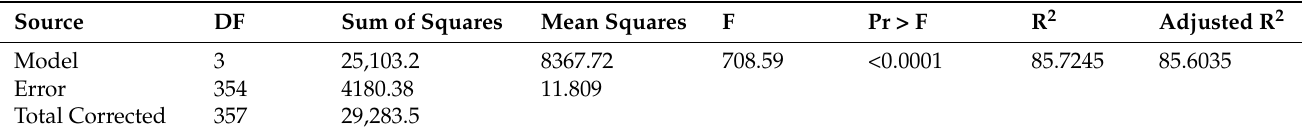
Table 6. Statistical evaluation of the Statgraphic model summary for the effluent WWQI.